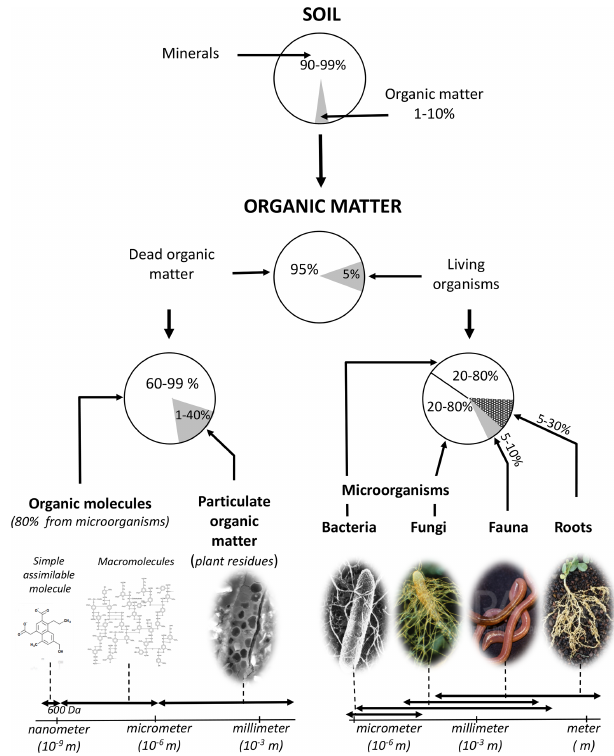
Figure 4. Nature, size range and indicative proportions of organic matter in < 2mm soil. Organic matter makes up less than 10% of soil constituents. The stock of C in a soil is mainly made up of dead organic matter molecules mainly resulting from microbial activity; adapted from Calvet et al.